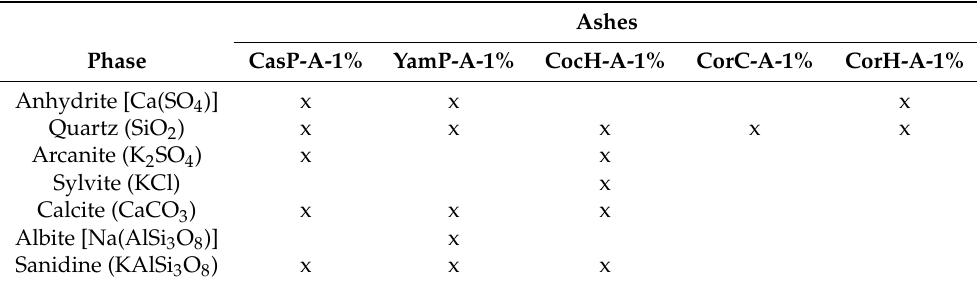
Table 5. Crystalline phases identified with XRD in the ash samples after the combustion of 1 w / v % acid-treated biomass fuels at 600 ◦